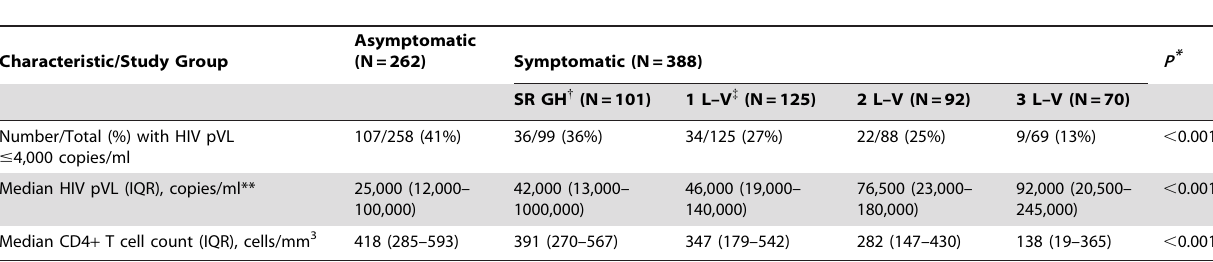
Table 2. Comparison of baseline HIV disease markers by study